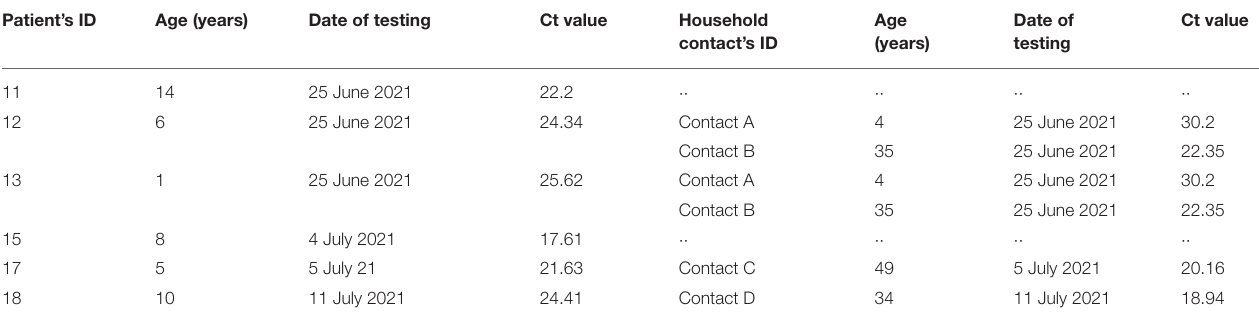
TABLE 4 | Results from RT-PCR for SARS-CoV-2 from six Delta pediatric cases and their household contacts at Murni Teguh Memorial Hospital Medan. Patient’s